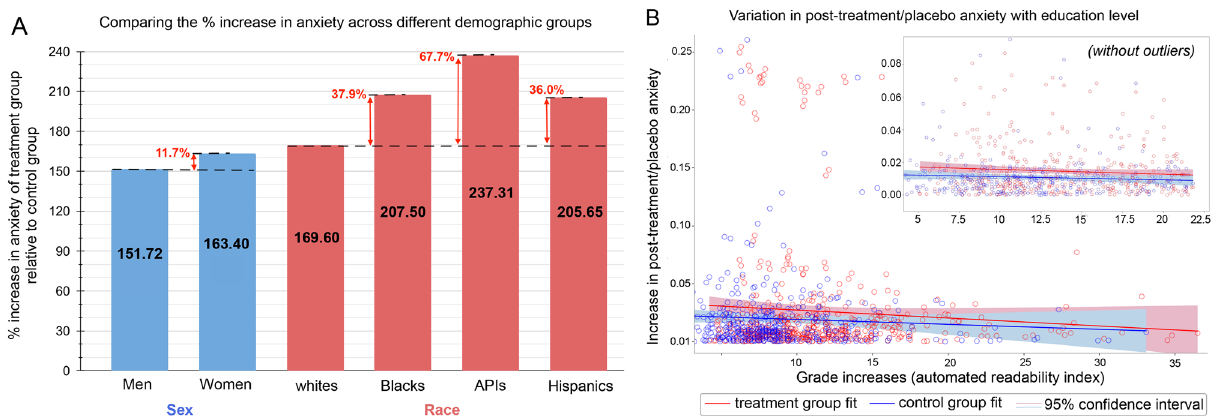
Figure 2. Results from socio-demographic analysis; relative increase in anxiety levels with respect to sex and race ( A ), and education level ( B ). We show the variation in experienced anxiety across different demographic axes in A . Each bar represents the percentage increase in post-treatment anxiety levels of individuals in the treatment groups with respect to their control group counterparts. We observe that women and racial minorities are more vulnerable to experiencing exacerbated anxiety as a result of sharing misinformation when compared to men and whites, respectively. The variation in experienced anxiety as a function of automated readability index is shown in B (higher ARI corresponds to higher education level). Each circle represents a user in our analysis; the lines of best fit were obtained using ordinary least squares regression. Shaded regions represent the 95% confidence intervals for the treatment and control groups. The trends suggest that higher education level acts as a cushion against the effect of sharing misinformation on experiencing exacerbated anxiety. In inset, we observe similar trends after removing the outliers (i.e., outside of the µ ± 2 σ